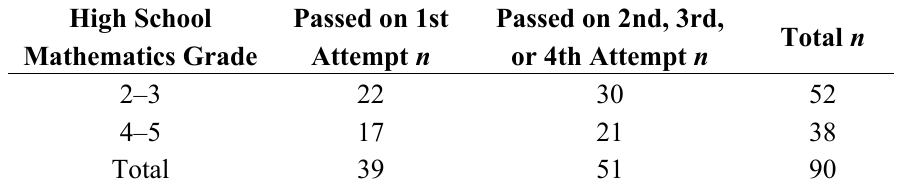
Table 2. Numbers of students who passed on the first and second, third, and fourth attempts, used in the chi-square and Fisher’s exact